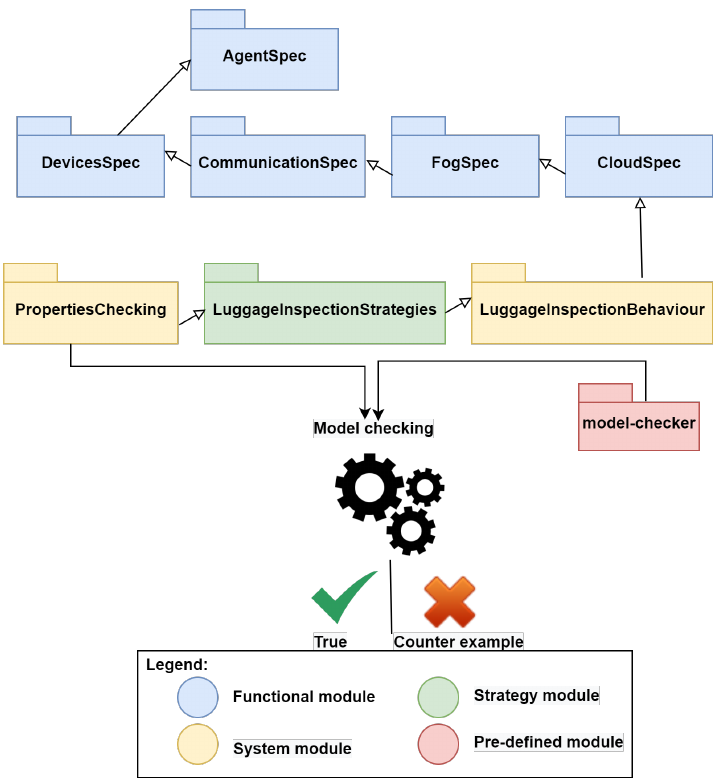
Figure 7. LIS modules under Maude